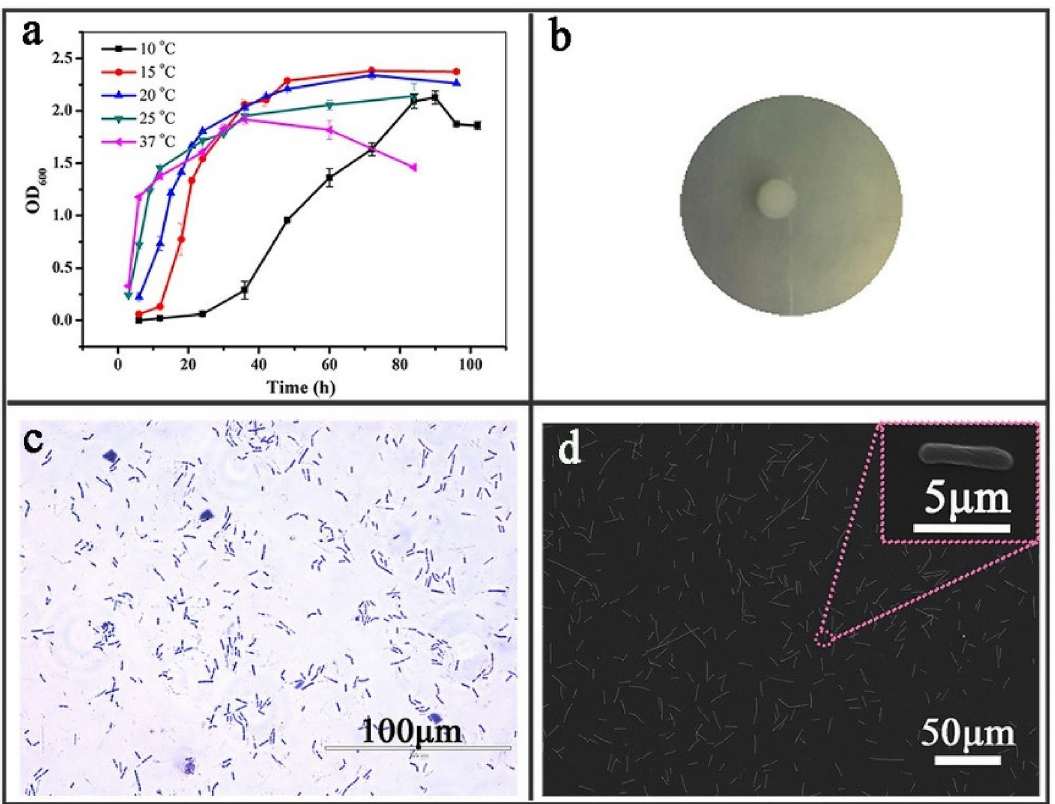
Figure 1. ( a ) The growth curve of the strain TK-2 at different temperatures. ( b ) The morphology of TK-2 on the medium. ( c , d ) The optical photos of the strain TK-2 under microscope and